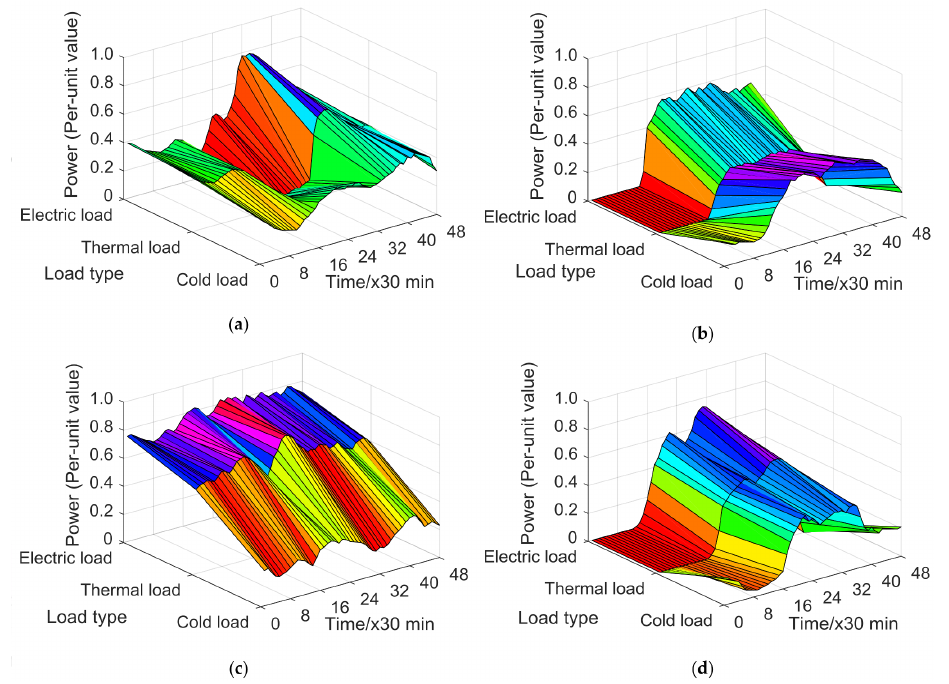
Figure 1. The typical timing characteristic curves of the electric/thermal/cold loads in various functional districts.